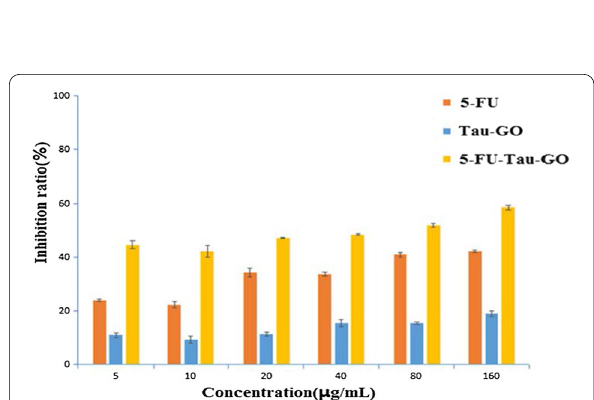
Fig. 11 The viability of different concentrations of 5-FU, Tau-GO, and